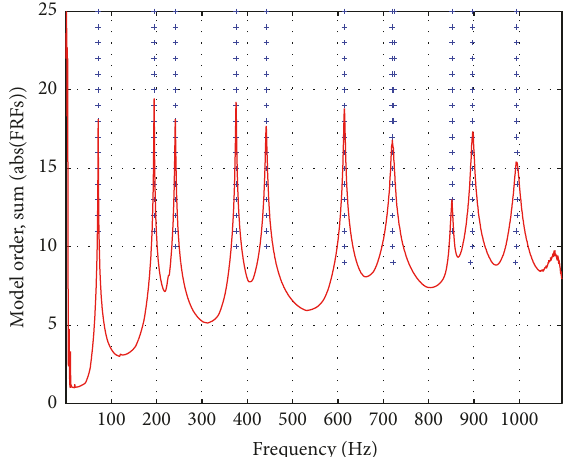
Figure 7: Stabilization diagram for the damping ratios. Each “ ∗ ” corresponds to a pair natural frequency-damping ratio, given the model order 𝑛 (ranging from 1 to 25). For some modes, for example, mode 2 at about 200 Hz, many points are almost completely